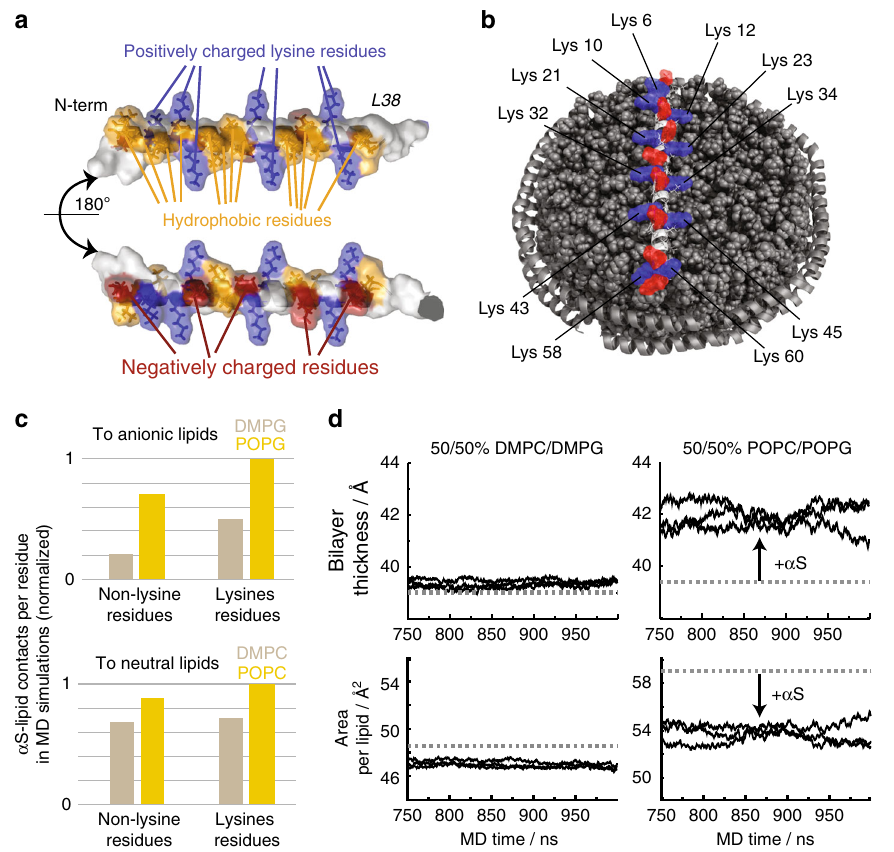
Fig. 4 α S – lipid interaction potentially modulates membrane plasticity. a Molecular features of α S ’ s key lipid binding mode (residues 1 – 38), including periodically and symmetrically appearing lysine residues (blue) that form a positively charged “ grid ” (see text for more details). b Model of α S 1-61 -nanodisc interaction (drawn to scale), lysine (blue) and negatively charged residues (red) are highlighted. c α S-to-lipid contacts ( < 4 Å) per residue as occurring during the time course of MD simulations. Normalized values for interactions with anionic lipids (upper diagram) or neutral lipids (lower diagram) differentiating between lysines and all other residues as well as between gel/ fl uid-phase membranes (beige/yellow bars), respectively. d Bilayer thickness (upper panels) and area per lipid (lower panels) during the end of MD simulations in the presence (solid lines, three independent simulations) and in the absence of α S (dashed line). While simulations in the gel phase show no considerable effect ( d , left panels), a clear trend toward a more ordered state for the fl uid phase membrane, induced by the presence of α S, is visible by an increase bilayer thickness and reduced area per lipid ( d , right